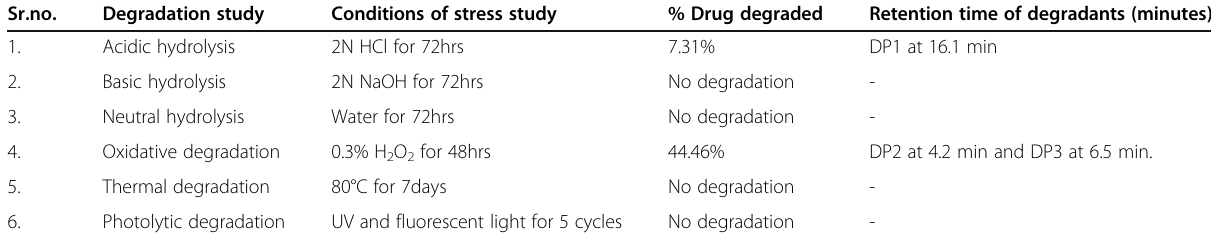
Table 1 Summary of degradation behaviour of VEN